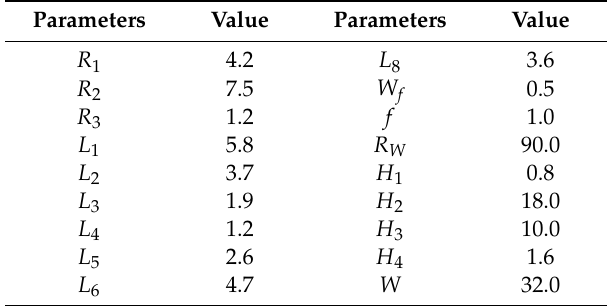
Table 1. Parameters of the proposed antenna (units: mm).